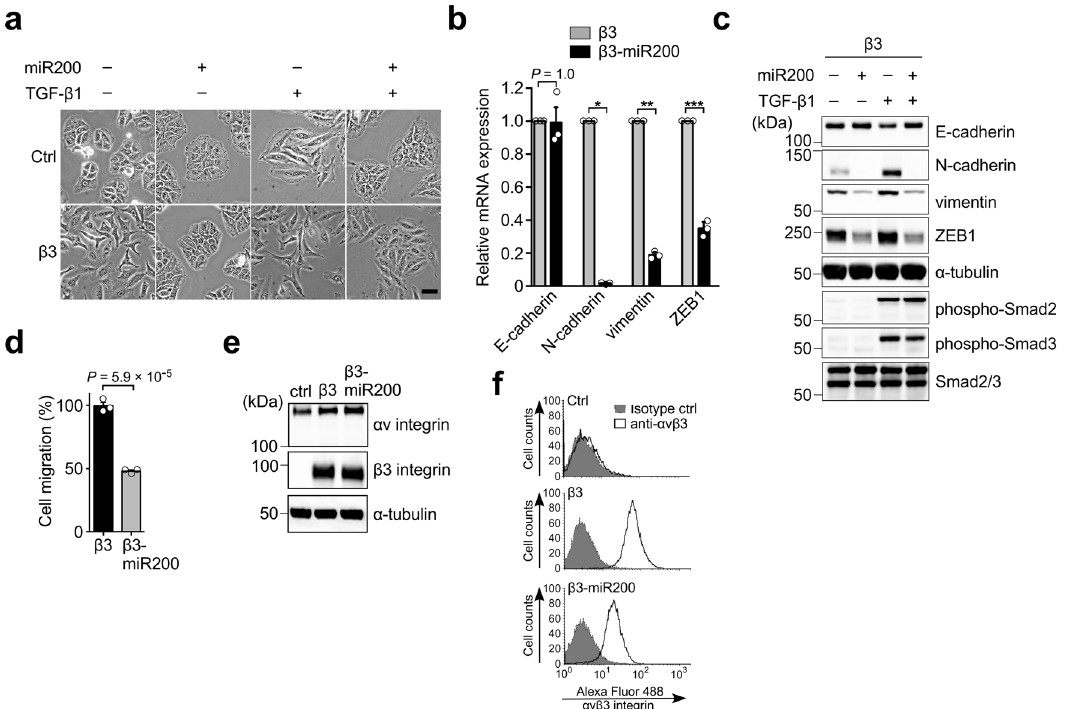
Fig. 8 miR-200 family can prevent α v β 3 integrin-mediated partial EMT. a Cell morphology of control A549 cells, β 3-A549 cells, and control and β 3- A549 cells stably expressing the miR-200 family ( β 3-miR200-A549 cells) with or without 2 ng/ml TGF- β 1 treatment for 24 h. Scale bar, 100 µ m. b Relative mRNA expression levels (qRT-PCR) of EMT markers in β 3-A549 and β 3-miR200-A549 cells. One-way ANOVA and Bonferroni post-hoc test, mean ± s.e. m. of three independent assays conducted in triplicate. * P = 4.2 × 10 − 11 , ** P = 7.6 × 10 − 10 , *** P = 2.1 × 10 − 8 . c Western blotting of EMT markers in β 3-A549 and β 3-miR200-A549 cells with or without 2 ng/ml TGF- β 1 treatment for 24 h. d Effect of the miR-200 family expression on the cell migration of β 3-A549 cells. Two-tailed unpaired Student ’ s t -test, mean ± s.e.m. of three independent assays conducted in triplicate. e Western blotting analysis of the intracellular expression levels of α v and β 3 integrins in control, β 3- and β 3-miR200-A549 cells. f FACS analysis of the cell surface expression of α v β 3 integrin in control, β 3-, and β 3-miR200-A549 cells. The source data are provided in Supplementary Data 1. Unprocessed blot images in ( c and e ) are shown in Supplementary Fig. Methods EDTA, 0.05% Tween 20, pH9.0) and subjected to microwave treatment for 15min Cell culture, transfection, and infection . Human lung cancer cell lines A549 and for antigen retrieval. The tissue samples were deparaf fi nized, rehydrated, and immersed in 0.3% H 2 O 2 in methanol for 20 min at room temperature to inactivate human embryonic kidney cell lines 293 T were obtained from the RIKEN BRC endogenous peroxidase. Samples were blocked with 5% skim milk/PBS for 1h at through the National Bio-Resource Project of the MEXT, Japan. Modi fi ed human room temperature, incubated with anti- β 3 integrin primary antibody (#ab179473, 293 phoenix cells were a gift from Dr. M Peter Marinkovich (Stanford University, Abcam, 1:800) in 5% skim milk/PBS overnight at 4°C, and rinsed three times in Stanford, CA). These cells were maintained in Dulbecco ’ s modi fi ed Eagle ’ s medium PBS for 5min. The sections were incubated with peroxidase-labeled secondary (DMEM; #043-30085, WAKO) and were supplemented with 10% fetal bovine antibody [Histo fi ne simple stain MAX-PO (MULTI) kit, #424152, Nichirei Corp.] serum (FBS), penicillin, and streptomycin sulfate (#168-23191, WAKO). Human for 30min at room temperature. After washing three times with PBS for 5min, lung cancer cell lines, H358, H460, and H1975 cells, were purchased from the peroxidase was visualized using Histo fi ne DAB substrate kit (#425011, Nichirei American Type Culture Collection (ATCC), and were grown in RPMI-1640 (#189- Corp.), and slides were counterstained with Meyer ’ s hematoxylin solution (#131- 02025, WAKO), supplemented with 10% FBS, 2.5g/l D ( + )-glucose, 1mM sodium 09665, WAKO). Images were obtained using a Nanozoomer-SQ (#C13140-L04, pyruvate, and 10mM HEPES. Retroviruses were produced from 293 phoenix cells Hamamatsu) and analyzed using NDPview2 software. Histological scores were transfected with Lipofectamine LTX & Plus reagent (#15338-030, Life Technolo- determined based on the β 3 integrin staining intensity in a blinded fashion by two gies) and LZRS blast retroviral vectors. The cells were then selected with 5µg/ml independent investigators. In addition to carcinoma cells, some host-reactive puromycin (#P8833, Sigma-Aldrich). Lentiviruses were produced from 293T cells stromal cells were also stained, but these have been excluded from the following using pLKO.1 vectors and the Trans-Lentiviral shRNA Packaging kit (#TLP5912, analyses. GE Healthcare) according to the manufacturer ’ s instructions. Viral supernatant was passed through a 0.45µm fi lter and stored at − 80 °C until use. Infection was performed as described previously 40 . One day before infection, 4× 10 5 cells in 3ml Reagents, plasmids, and shRNAs . The TGF- β 1 receptor inhibitor SB431542 was growth media were plated in a six-well plate (#353846, BD Falcon). After incu- from WAKO (#192-16541). Recombinant human TGF- β 1 was from Peprotech bation with 5µg/ml polybrene (#10768-9, Sigma-Aldrich) for 15 min, the media (#100-21). Retroviral LZRS and lacZ-LZRS blast expression vectors were a gift from were exchanged to viral supernatant, and another 5µg/ml polybrene was added. Dr. M Peter Marinkovich (Stanford University, Stanford, CA). LZRS blast After centrifuging the plate at 1200 rpm for 1 h at 32 °C using a Hitachi CR22N expression vector encoding β 3 integrin was prepared as previously described 41 . All centrifuge machine, the viral supernatant was replaced with fresh growth medium. mutants were generated by oligonucleotide site-directed mutagenesis. A retroviral To establish a cell line, cells were selected with 10 µg/ml blasticidin S (#203350, lacZ-LZRS blast expression vector was used as a control. All cDNA sequences were Calbiochem) for retroviral infection and 5µg/ml puromycin for lentiviral infection. veri fi ed by DNA sequencing. pLKO.1 lentiviral plasmids encoding shRNAs tar- For all experiments, all cells were cultured less than 6 months after purchasing or geting human β 3 integrin (clones TRCN0000003234 and TRCN0000003236) and receiving them, and were tested for mycoplasma contamination. Cell morphology control shRNA (#RHS4459) were from Dharmacon. Lentiviral vector pLenti4.1 Ex was observed under an IX71 phase contrast microscope (Olympus), and photo- miR200b-200a-429 was a gift from Greg Goodall (Addgene #35533) 27 . graphs were taken. RNA extraction and quantitative RT-PCR . Total RNA was extracted using the NucleoSpin RNA Plus kit (#740984.50, Macherey-Nagel) and reverse-transcribed with the PrimeScript RT Master Mix kit (RR036A, Takara). Quantitative PCR